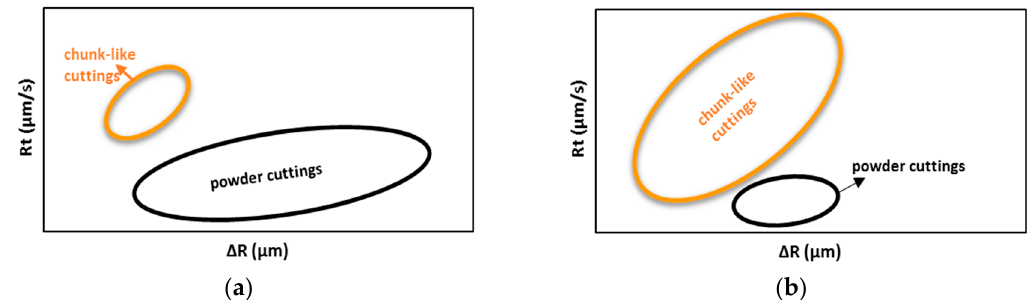
Figure 9. The evolution of R t versus ∆ R graphs (circular shapes represent the concentration of data points): ( a ) the DOC is shallow, ( b ) the DOC is deep.